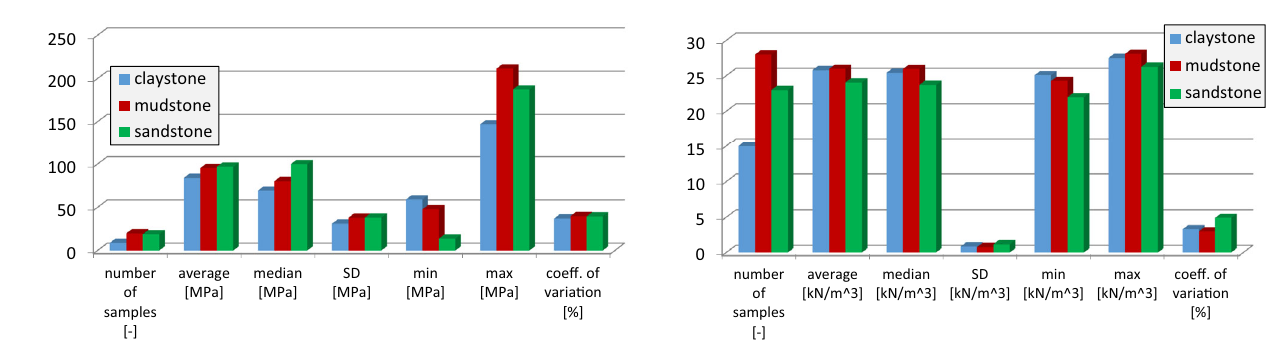
Fig. 5 Comparison of chosen statistical parameters for compressive strength data